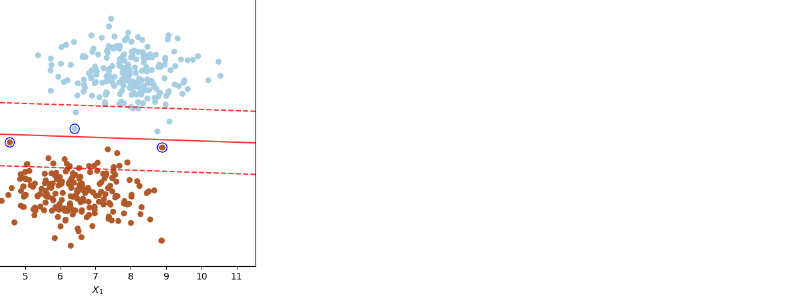
Figure 5. Graph of a polynomial SVM showing the hyperplane separating the samples from the